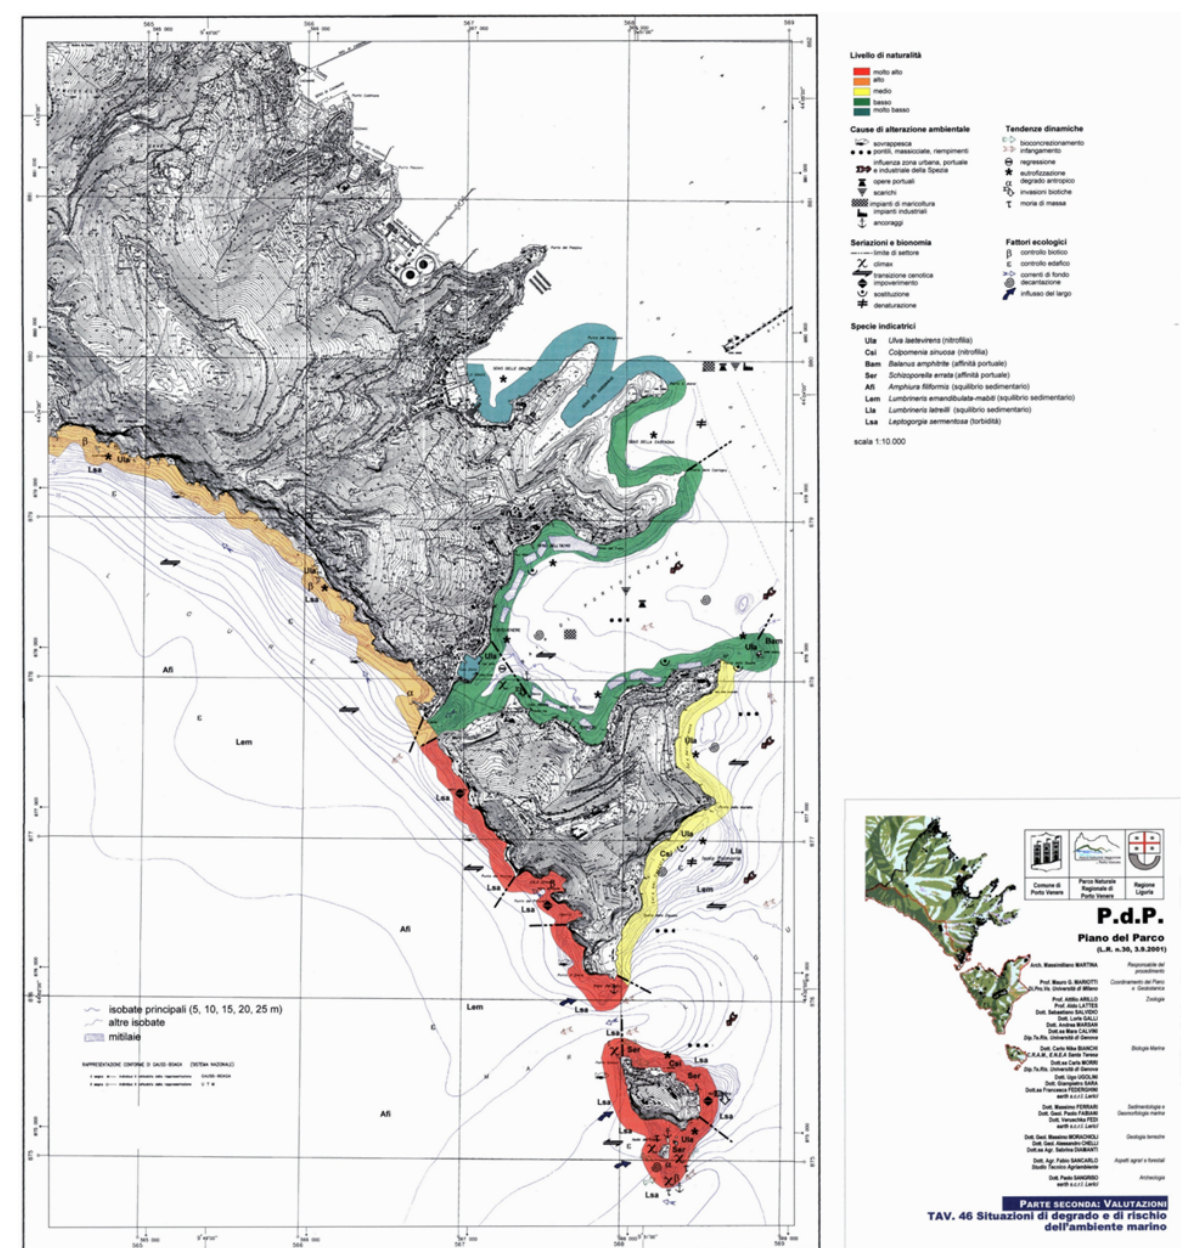
Figure 5. Reproduction at reduced scale of a map of the degradation and risk of the marine territory. The example illustrates the MPA “Arcipelago di Portovenere” (original scale 1:10,000). This and similar maps can be freely downloaded, at their full size, from the SEAMap site